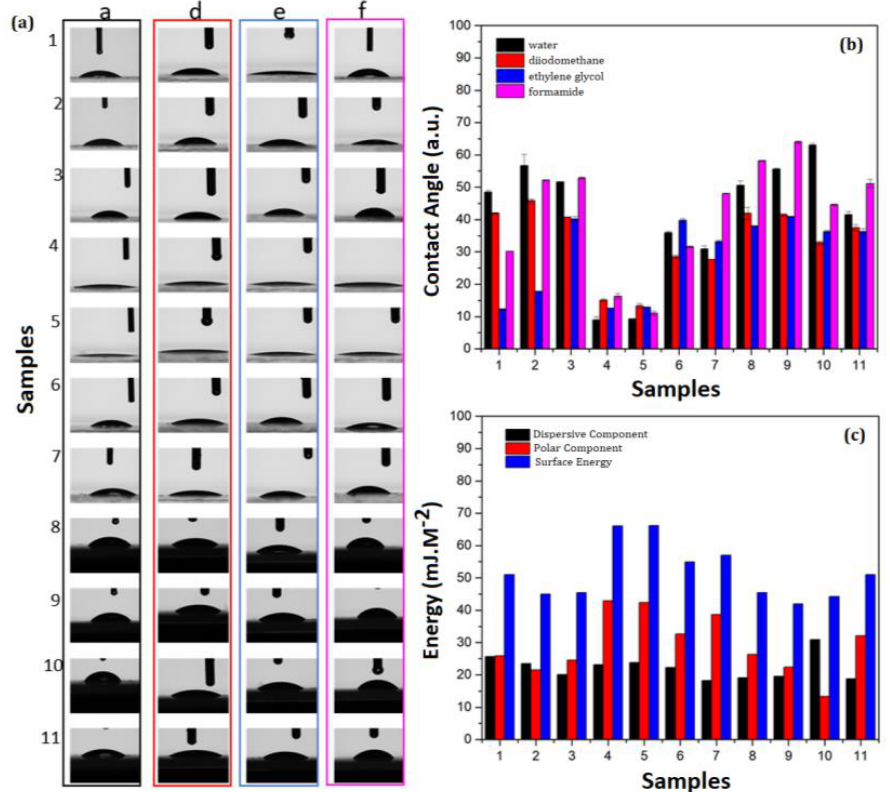
Figure 4. ( a ) Representation of the contact angle, ( b ) variation of the contact angle for the liquid- probes water, diiodomethane, ethylene glycol and formamide, and ( c ) surface energy and its polar and dispersive components for (1) glass, (2) A-DE-PVA, (3) A-DE-PVA-ALA, (4) B-SE-PEG, (5) B-SE-PEG -ALA, (6) C-SE-PEG-PVA, (7) C-SE-PEG-PVA-ALA, (8) D-SE-PVA (9)D-SE-PVA-ALA, (10) E-DE-PEG-PVA and (11) E-DE-PEG-PVA-ALA. Hydrophilicity was clear in System B (Figure 4b), reducing the contact angle about 80% in relation to water. The presence of 5-ALA decreased the contact angle in most sys- tems. However, Systems B and D presented contact angles similar to those of unloaded systems. In addition, the presence of 5-ALA implied a change of 34% to System E. Thus,